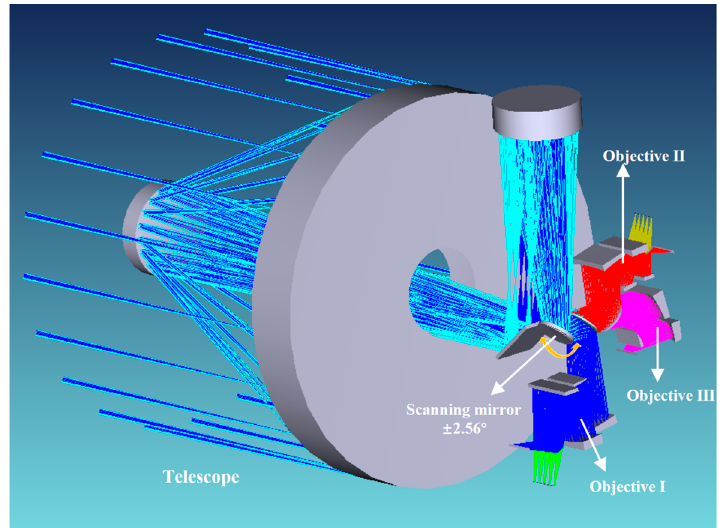
Figure 2. Optical path diagram of fore-optics.